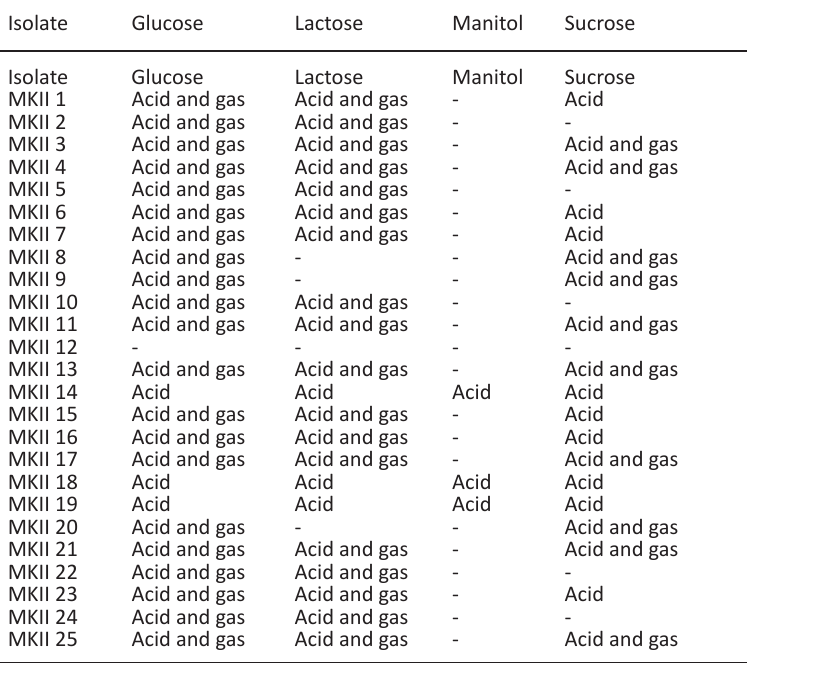
Table 4. Sugar fermentation test of the bacteria isolates from ice cream samples